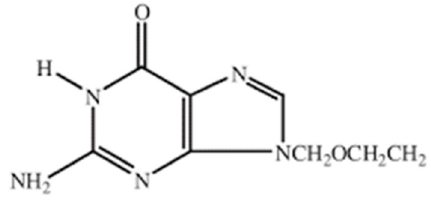
Figure 1. Structural unit of acyclovir.